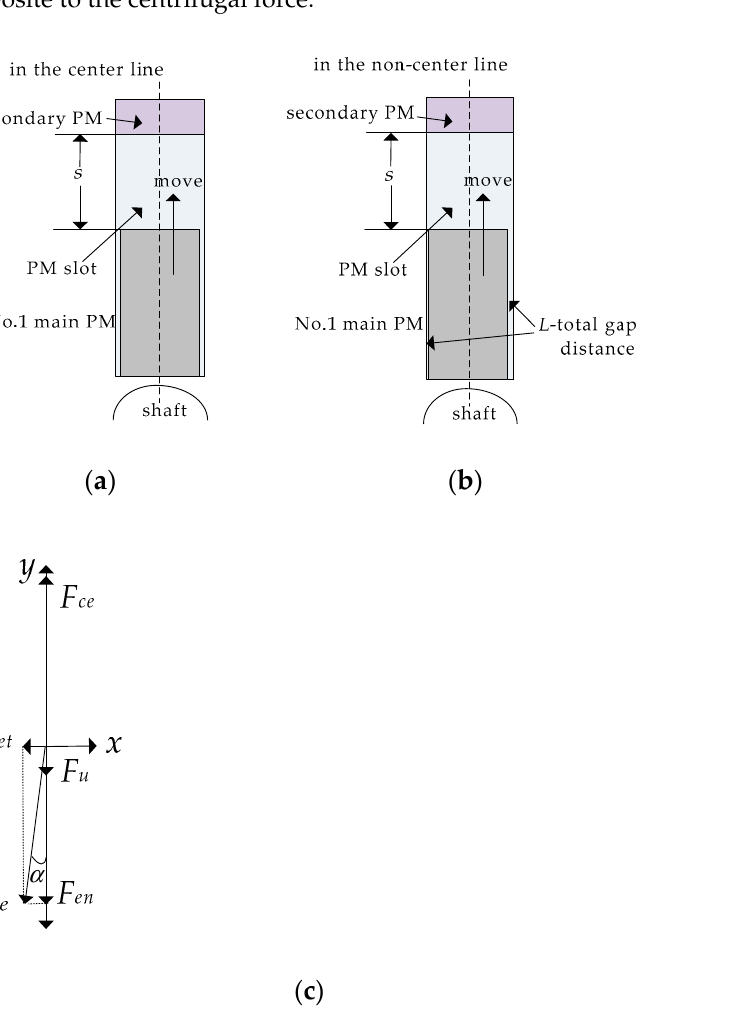
Figure 6. The forces on the main permanent magnets (PMs): ( a ) in the centerline of the PM slot; ( b ) in the non-centerline of the PM slot; ( c ) the force diagram. the non-centerline of the PM slot; ( c ) the force